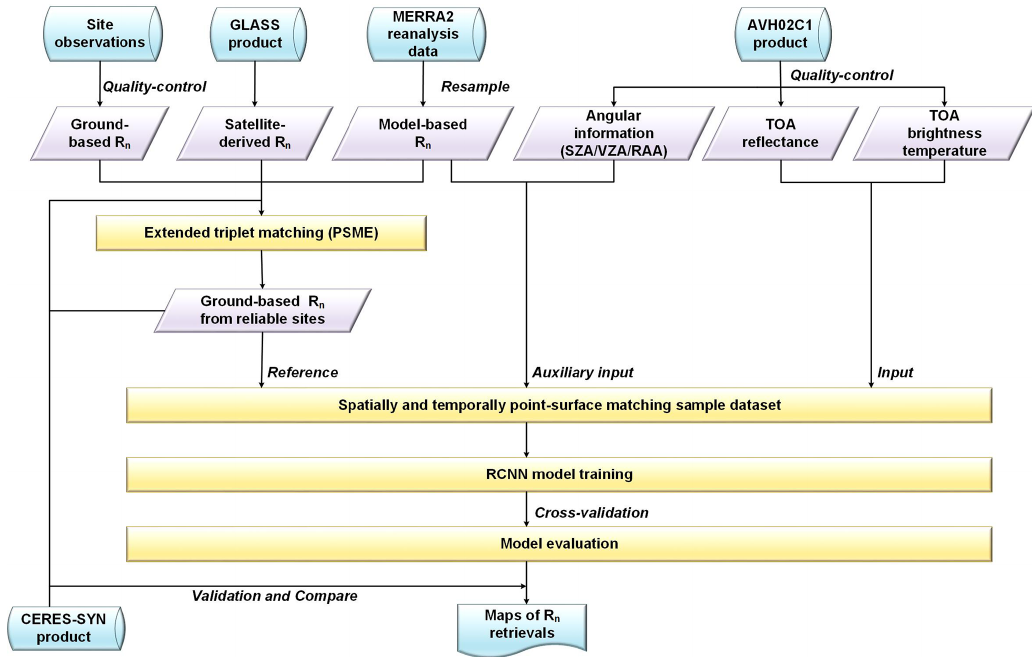
Figure 2. Workflow of RCNN-based point-surface matching estimation (PSME) method for surface R n retrievals. TOA: top of atmosphere; RCNN: residual convolution neural network; GLASS: Global Land Surface Satellite; CRES-SYN: Clouds and the Earth’s Radiant Energy System Synoptic; MERRA2: Modern-Era Retrospective analysis for Research and Applications, Version 2; SZA: solar zenith angle; VZA: viewing zenith angle; RAA: relative azimuth